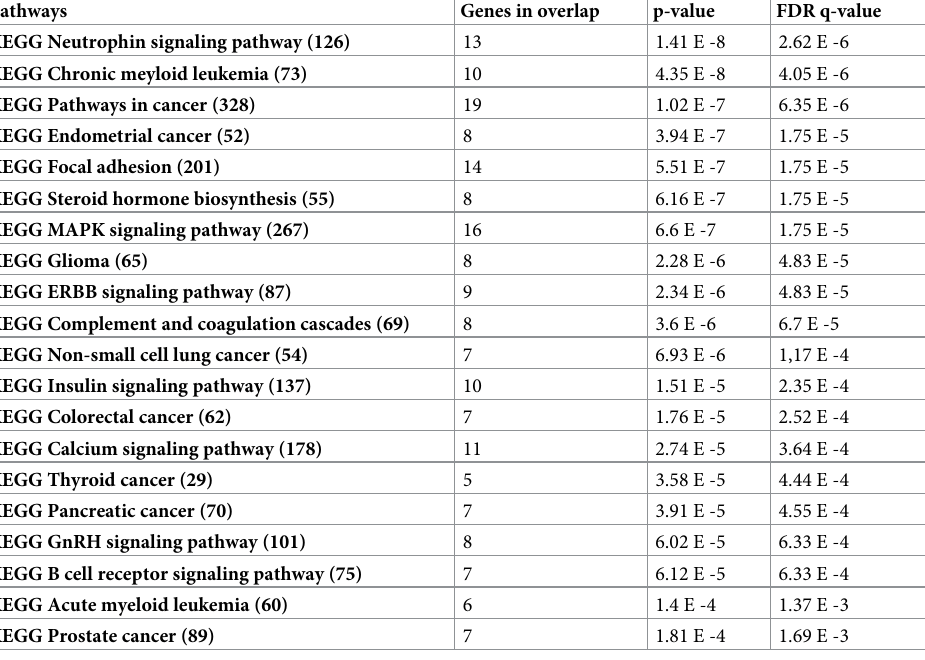
Table 7. Results from overlap analyses, Category 2. Pathway analysis of genes mutated in primary tumors and corre- sponding metastases, 606 in total.